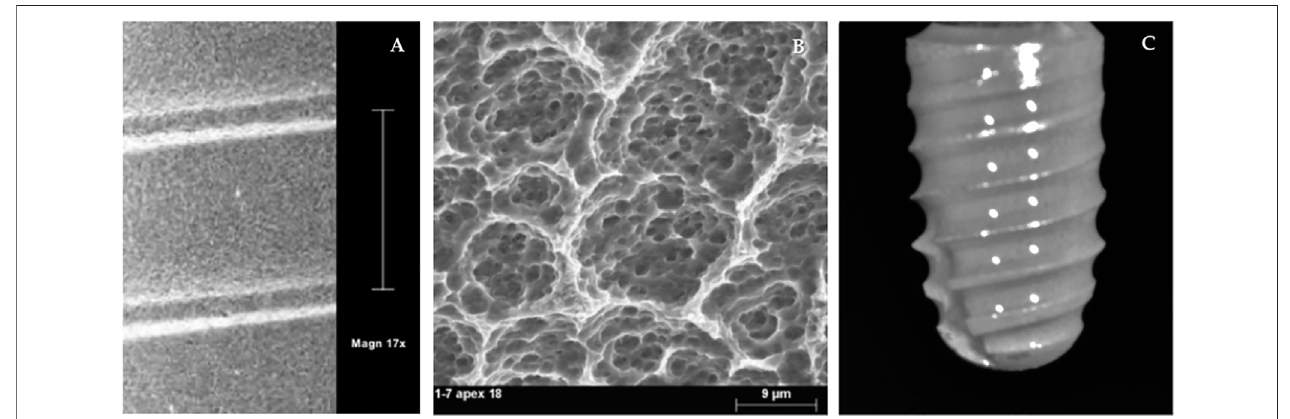
FIGURE 1 | Implant surface topography. CG surface (A,B) . ChtG coated implant surface (C)